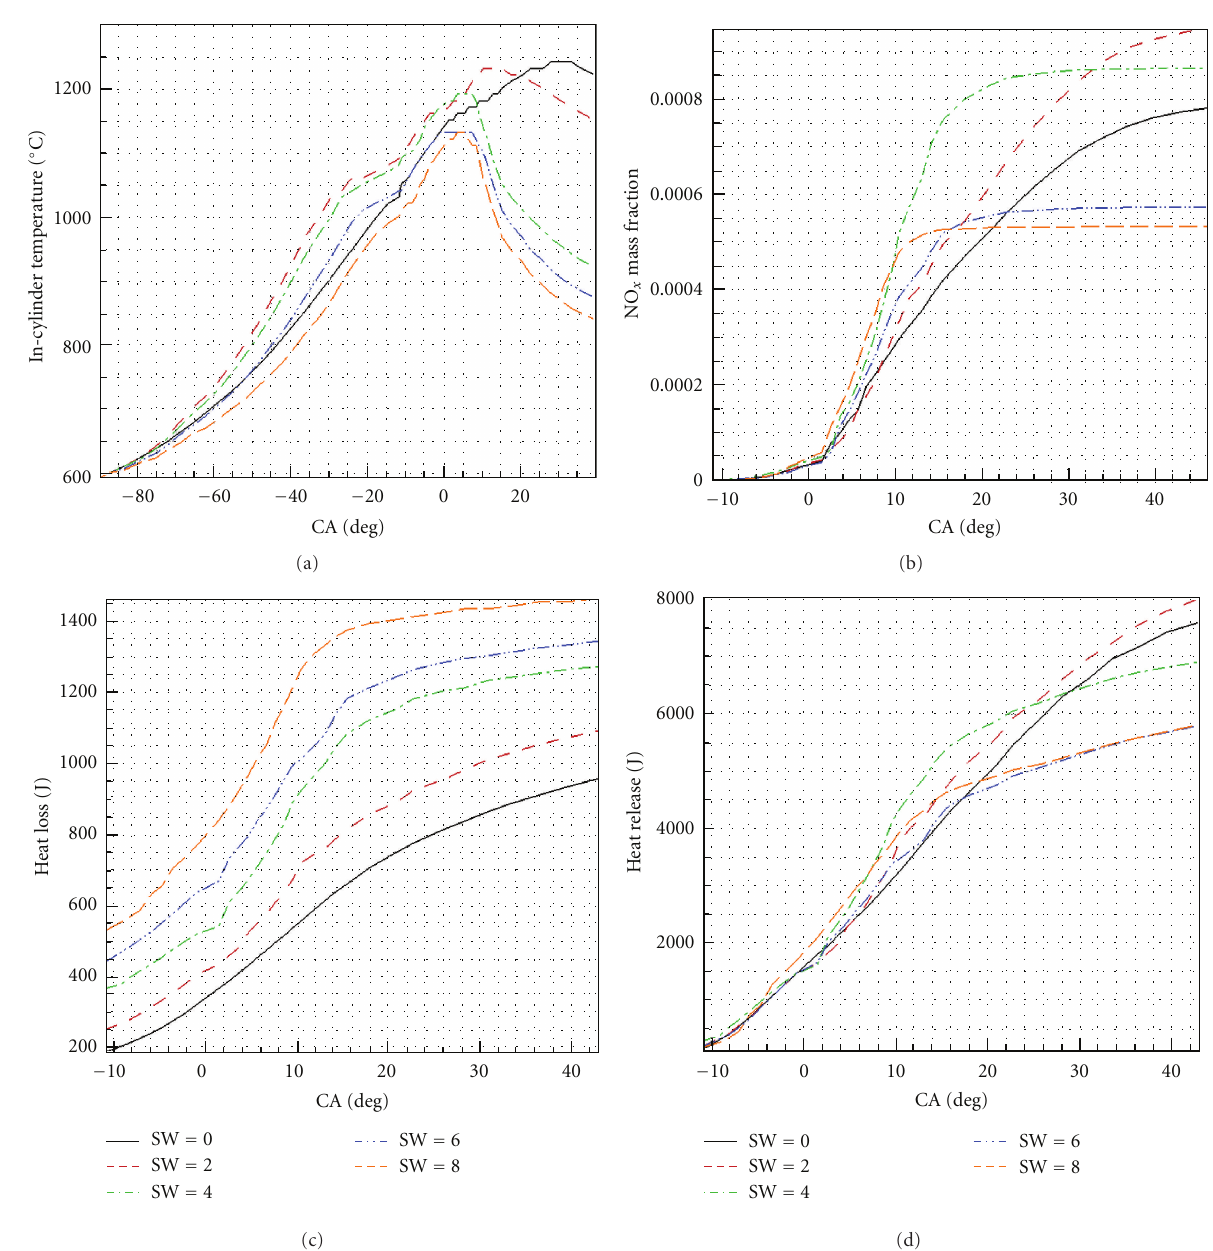
Figure 7: (a) E ff ect of initial swirl ratio on the in cylinder temperature and (b) e ff ect of initial swirl ratio on NO x formation. (c) e ff ect of initial swirl ratio on the heat loss through the walls and (d) e ff ect of initial swirl ratio on the heat release, predicted by